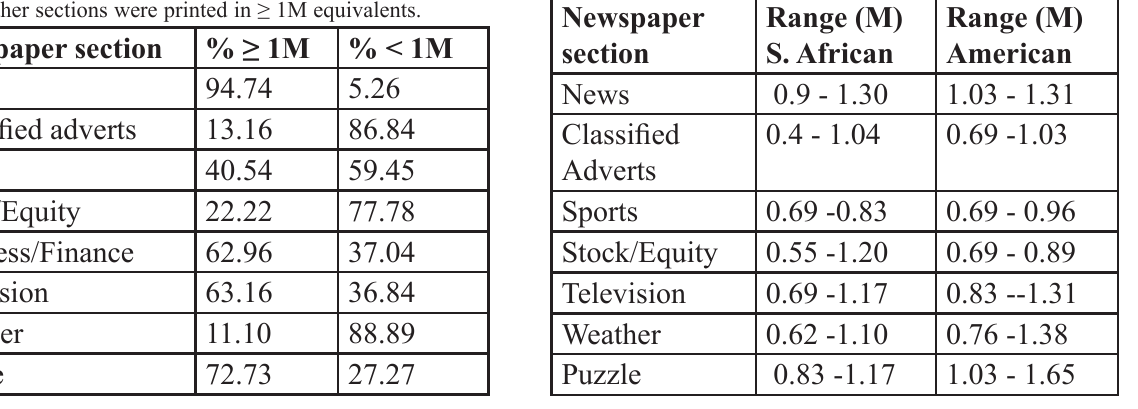
Table 3: A comparison of the South African (present study) and American 15 range of newspaper print sizes (M). The smallest sizes in each section of the South African newspapers were mostly smaller than the corresponding American values.